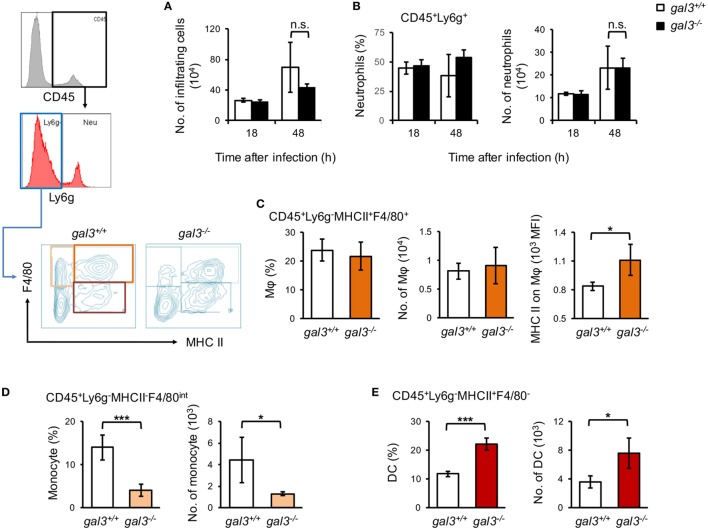
Gal3 regulates renal macrophage activation, monocytes, and dendritic cell recruitment in systemic Candida infection. Gal3+/+ and gal3−/− mice were infected intravenously with 5 × 105 of Candida. Kidneys were collected from infected mice at 18 and 48 h after infection. Renal infiltrating cells were isolated and stained for lineage specific markers as indicated. Total number of renal infiltrating cells (CD45+ cells) (A), the percentages and numbers of neutrophils (CD45+Ly6G+) (B), macrophages (Mφ, CD45+Ly6G−MHCII+F4/80+) (C), monocytes (CD45+Ly6G−MHCII−F4/80+) (D), and dendritic cells (CD45+Ly6G−MHCII+F4/80−) (E) in the kidney are shown. The levels of MHC class II expression on macrophages are shown as mean fluorescence intensity (C). n = 3. Data are presented as mean ± SD. *p < 0.05, ***p < 0.005, n.s., not significant, as analyzed by Mann–Whitney test.